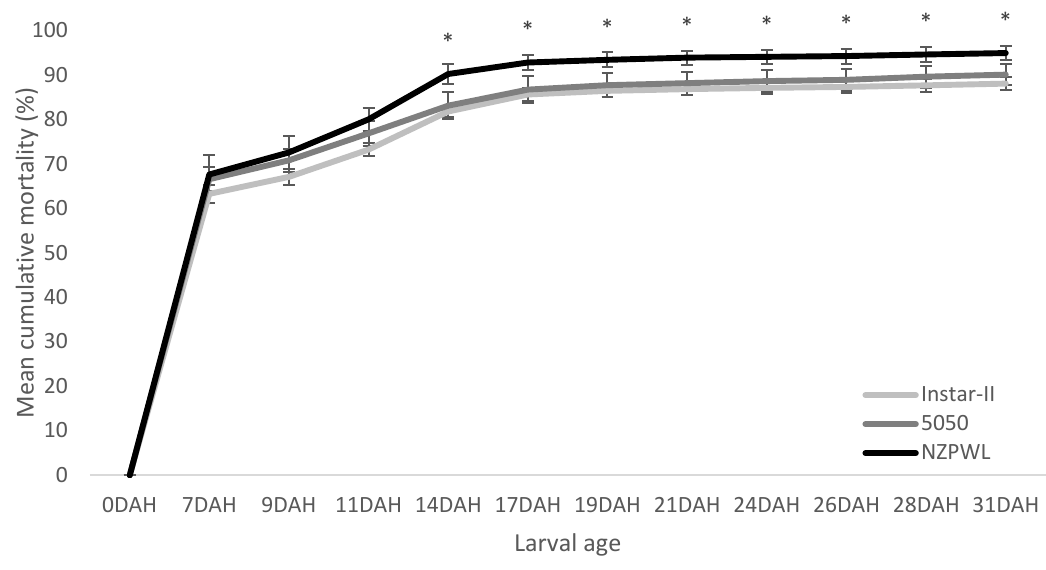
Figure 3. Mean cumulative mortality of larval giant k ō kopu in three different feed treatments, Instar-II+, 5050, and NZPWL, over the 28-day experimental period (mean ± SE). Sets of three treatment means marked with asterisk are significantly different for that DAH sampling event ( p < 0.05).